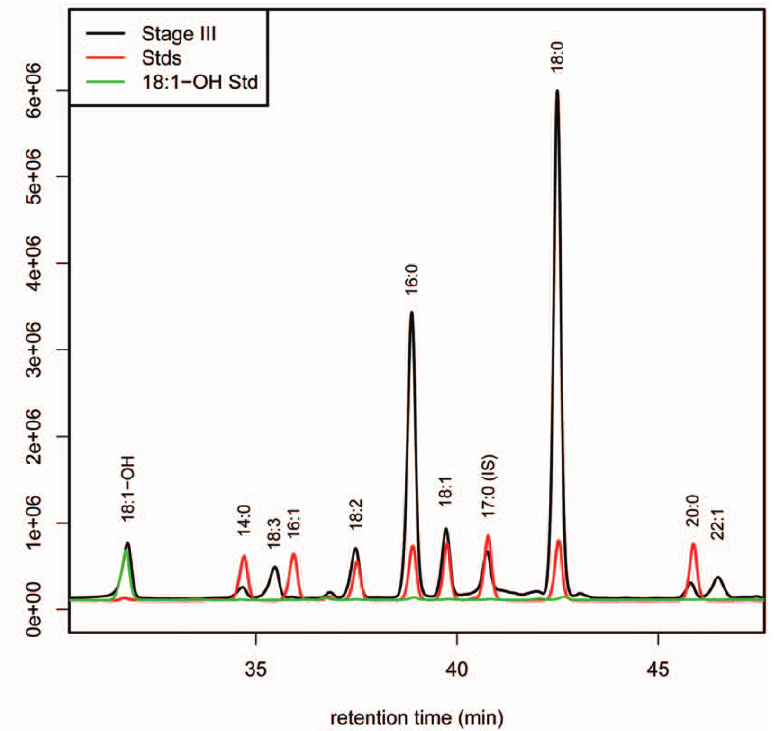
Figure 2. Acyl-CoA analysis of developing castor endosperm. A chromatogram of fluorescent acyl-CoA derivatives from developing castor endosperm stage III is shown - dark trace. Results from analysis of synthesised 18:1-OH-CoA (green line) and other acyl-CoA standards (red trace) are superimposed to confirm the indicated peak identities in the endosperm sample.